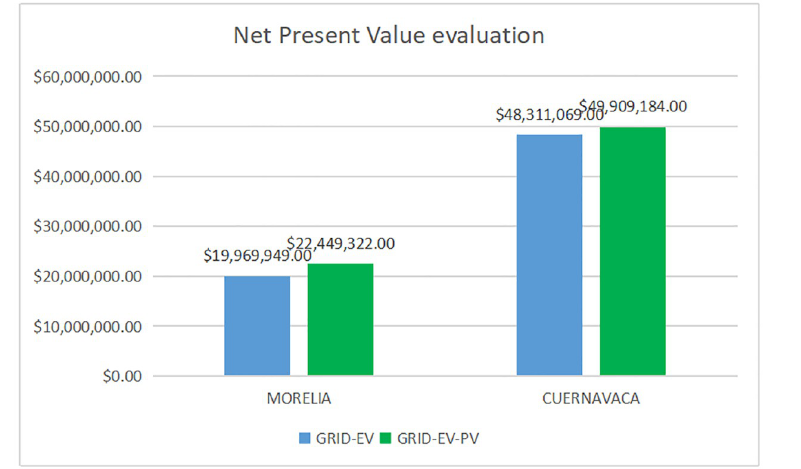
Fig 8. Net Present Value evaluation for two